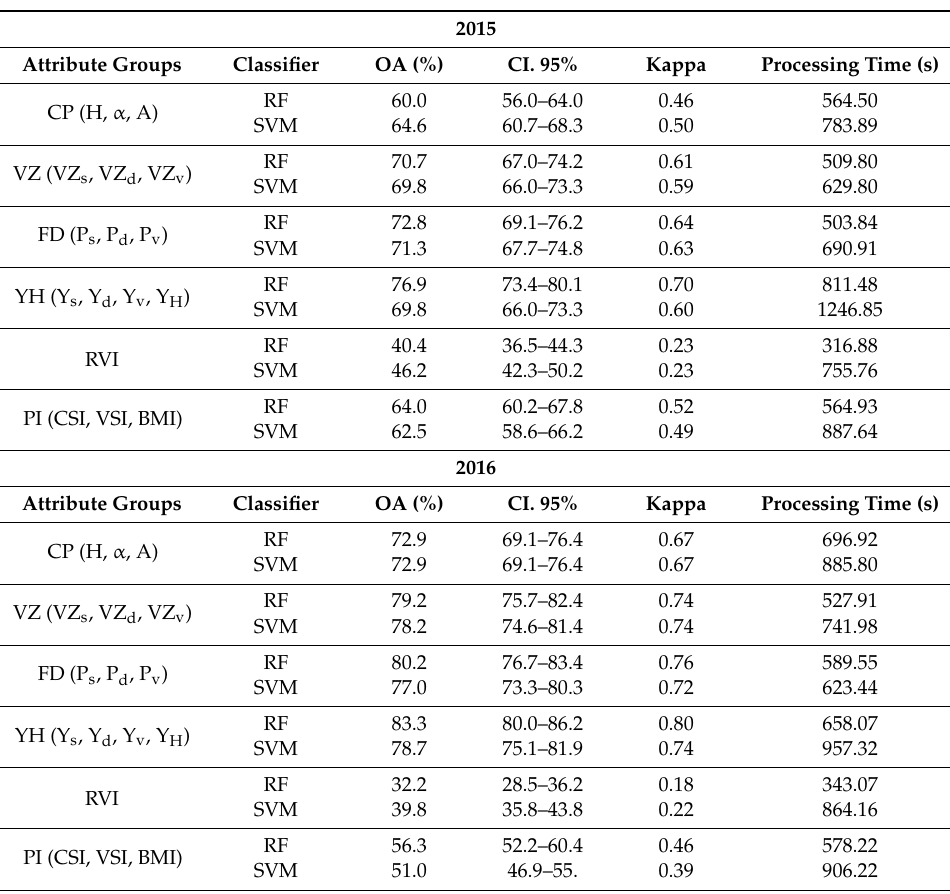
Table 6. Performance of di ff erent subsets of attributes for LULC classes classified by Random Forest (RF) and Support Vector Machine (SVM)